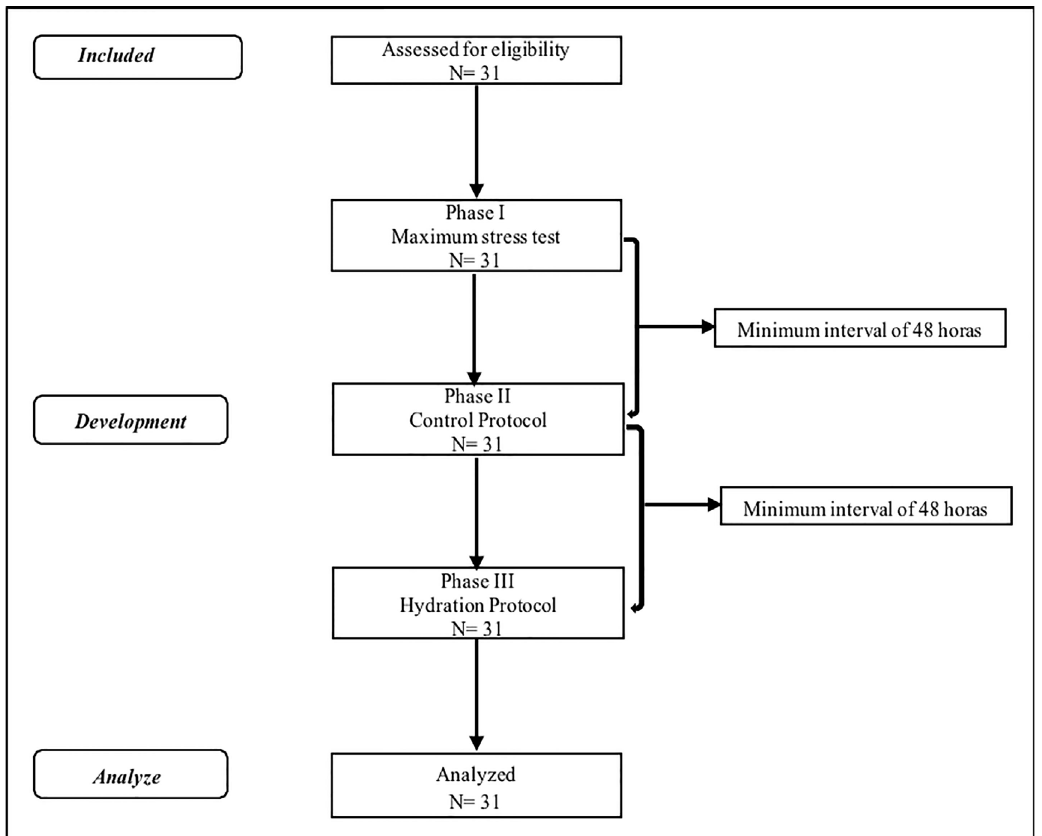
Figure 1 - Protocol